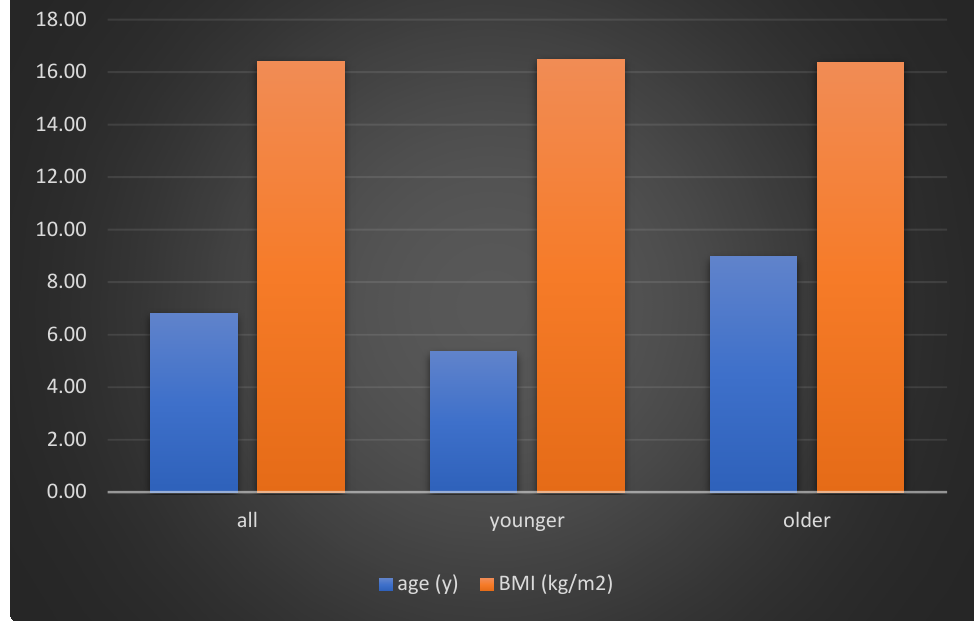
Figure 2. Histogram of the age and BMI distribution in the whole group and in the division of age groups.